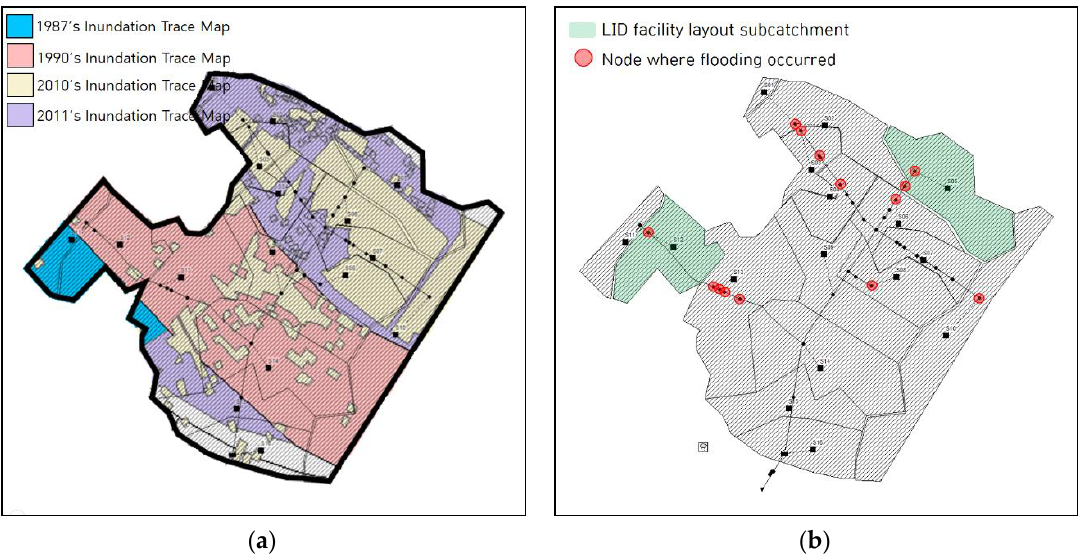
Figure 6. Status of the two subcatchments reflecting LID facilities using the SWMM model: ( a ) Past flood plain maps of the study area; ( b ) Selection of subcatchments to install LID facilities.